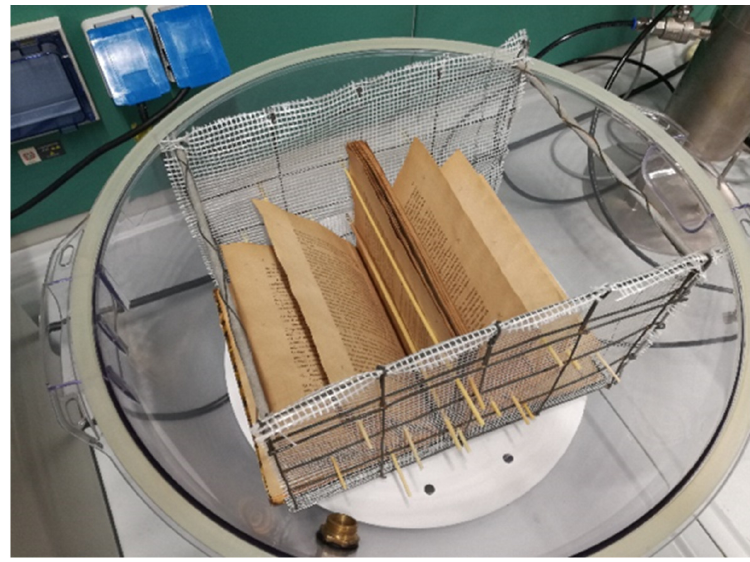
Figure 3. Details of the book holder grid with page spacers.